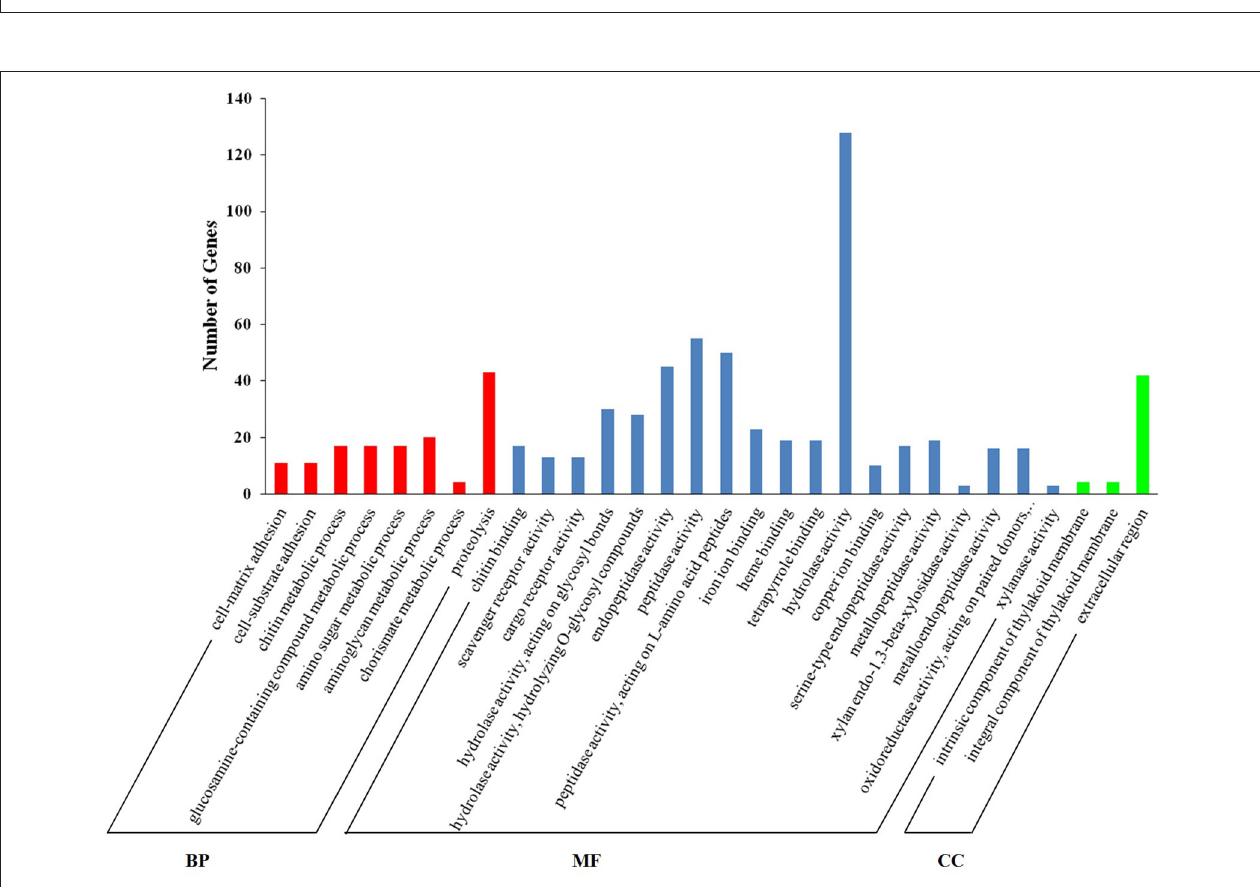
FIGURE 2 | Enriched GO terms in downregulated genes (M vs. A, comparison). The X-axis shows Gene Ontology (GO) terms in the sub-level of the GO three main domains. The Y-axis shows the number of DEGs annotated for each term.